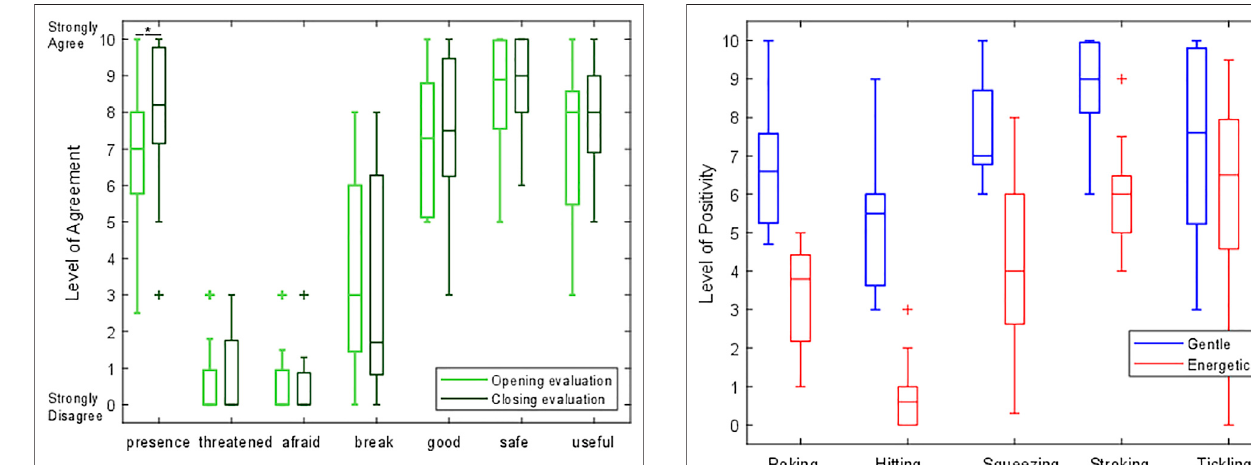
FIGURE 7 | A box-and-whisker plot showcasing participants ’ ratings of how they expect the robot would react in the future to the various touch gestures. A rating of 10 indicates a very positive response, and a rating of 0 indicates a very negative response. Touches with a gentle force intensity are shown in blue, and energetic gesture variations are colored